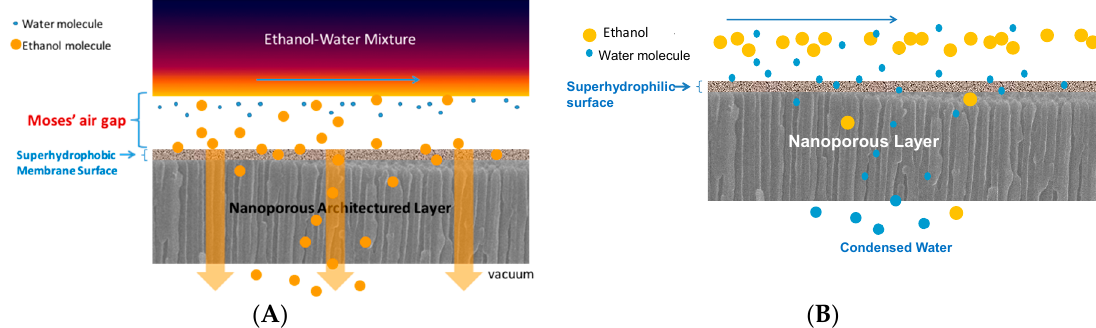
Figure 4. Schematic illustration of the separation principle of ( A ) superhydrophobic or ( B ) superhydrophilic membranes. The feed above the membrane surface can be either liquid or vapor mixtures.